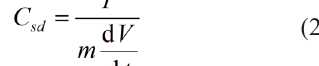
Figure 3: Single electrode specific capacitance ( C 500